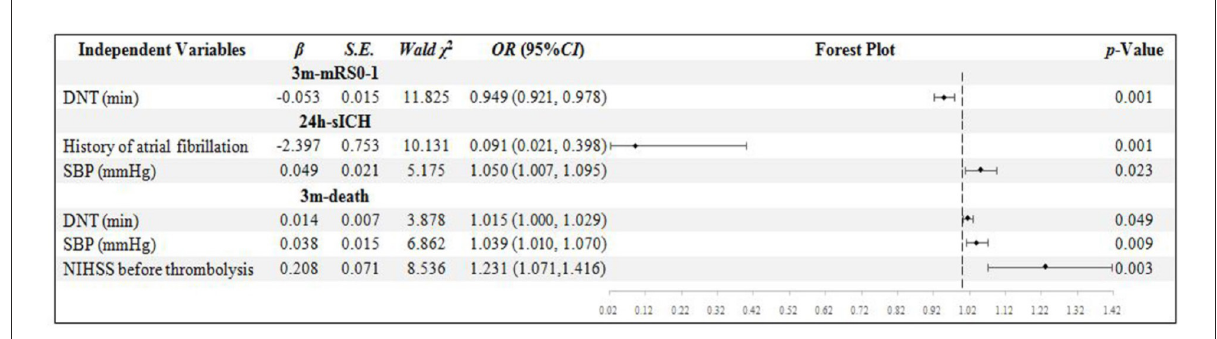
FIGURE1 Binary logistic regression analysis in NIHSS score ≥ 16 group. DNT, door to needle time; SBP, systolic blood pressure; NIHSS, National Institute of Health Stroke Scale; mRS, modified Rankin scale; sICH, symptomatic intracranial